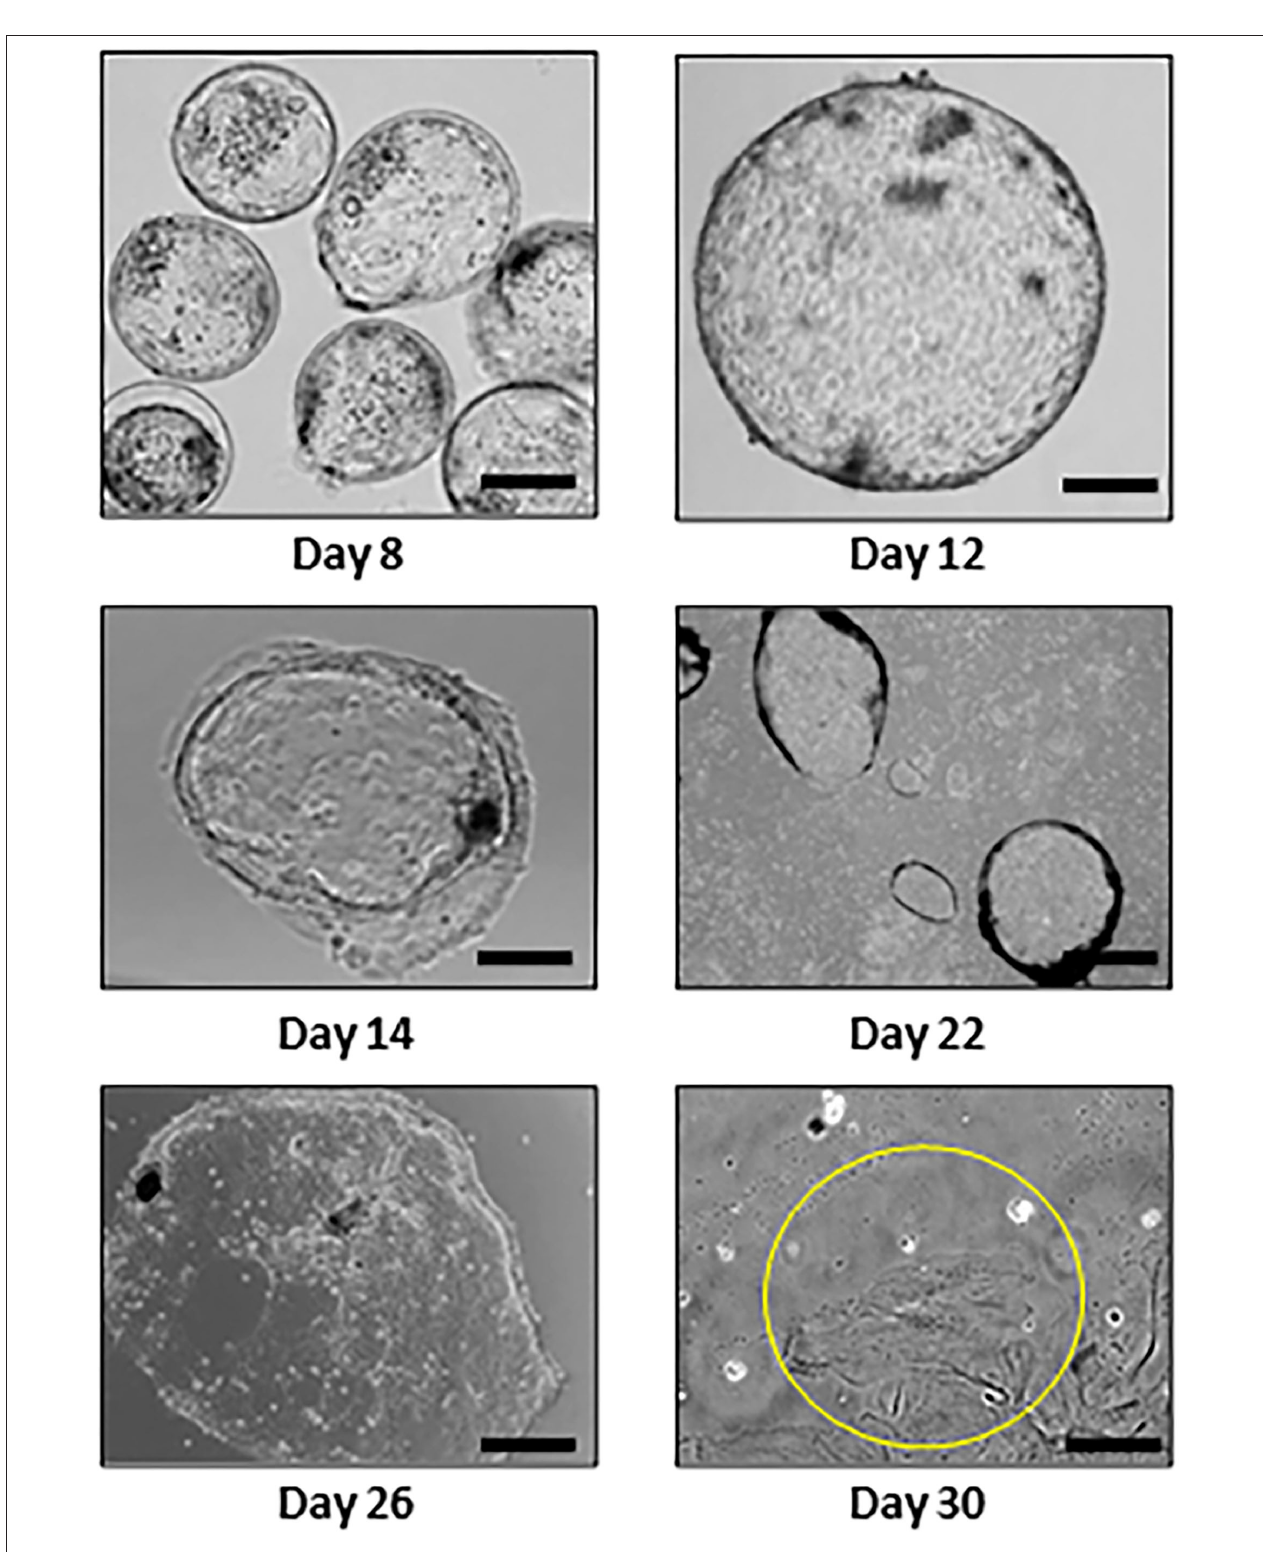
FIGURE 1 | Individual embryos and trophectoderm outgrowths during 30 days of in vitro culture (day 0 = insemination). The cells circled in yellow in the day 30 outgrowth are binucleated. Bar = 100 µ m.